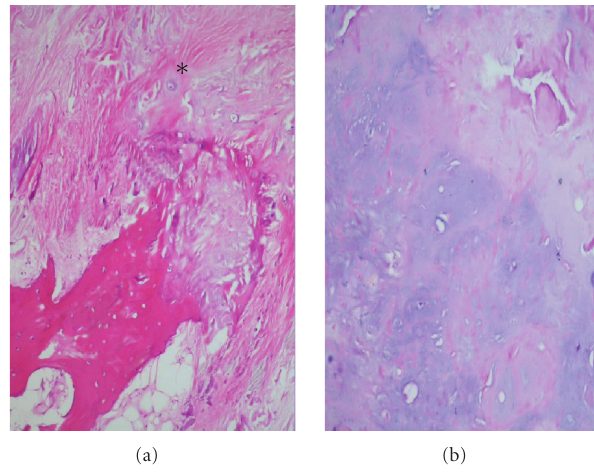
Figure 4: (a) Osseous metaplasia observed adjacent to amyloid deposition. Note the single chondrocytes spread in amyloid matrix (asterix) (hematoxlin eosin, × 10). (b) Areas presenting extensive chondroid metaplasia (hematoxlin eosin, ×